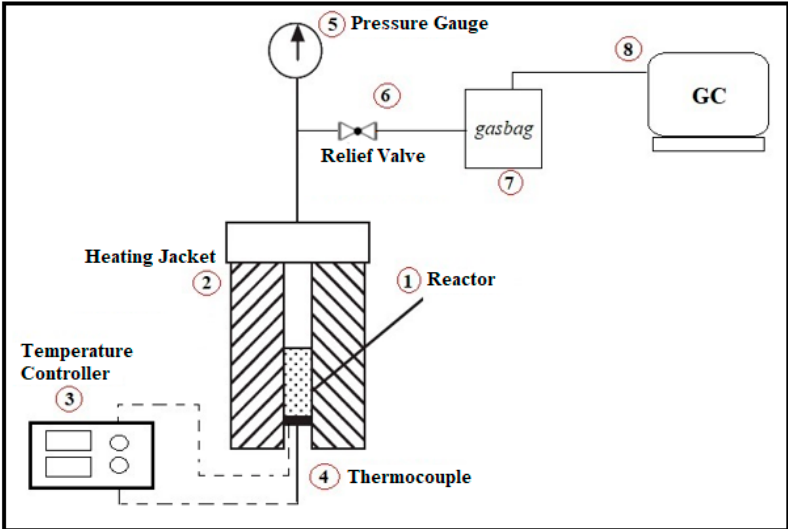
Figure 1. The reactor, made by Hastelloy, was designed to operate up to 600